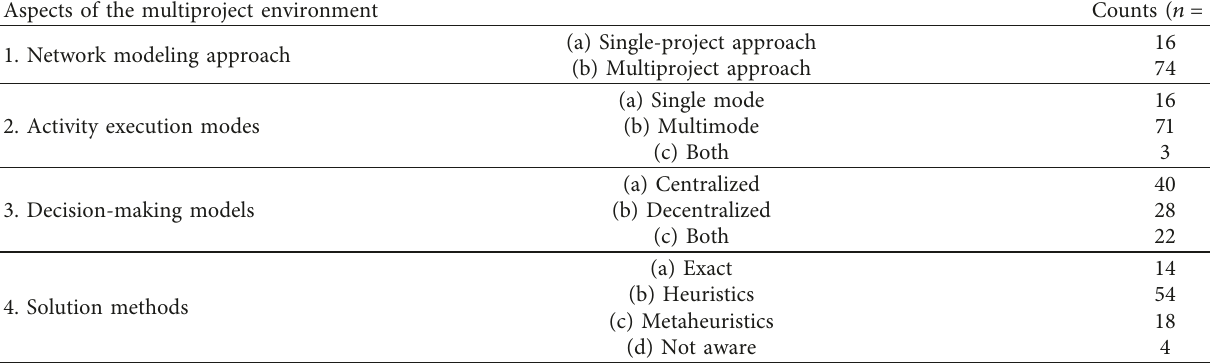
Table 9: Descriptive information on the various aspects of the multiproject environment. Aspects of the multiproject environment